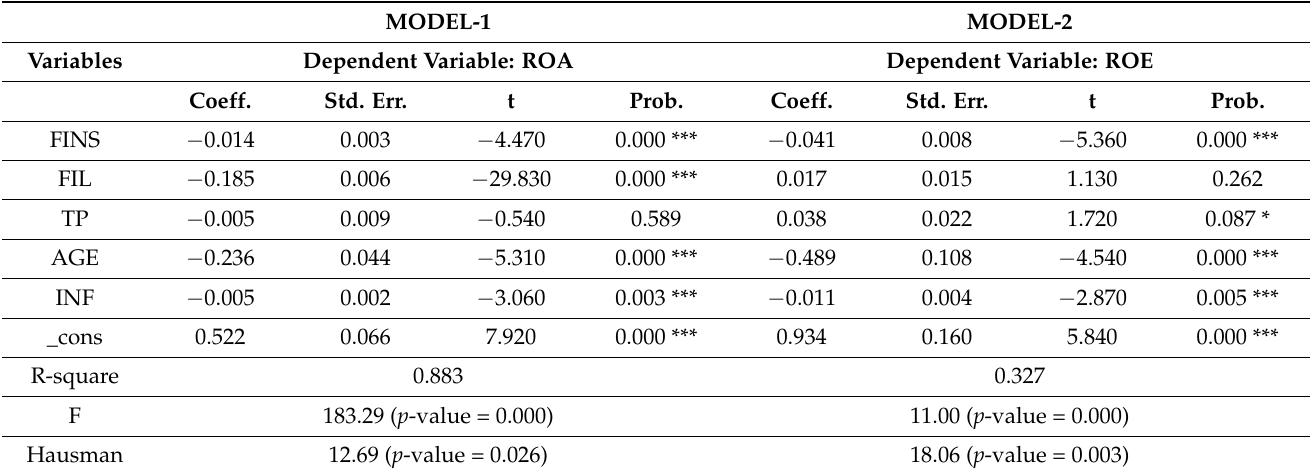
Table 8. Outcomes of fixed-effect regression